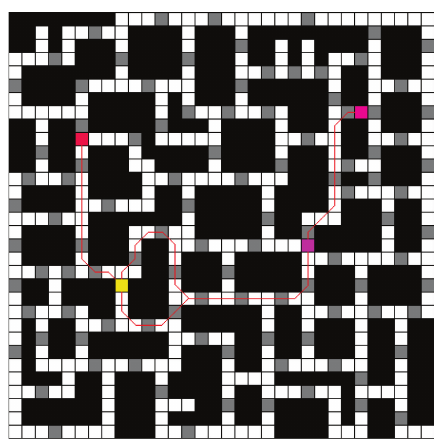
Figure 12: Combine and split trap